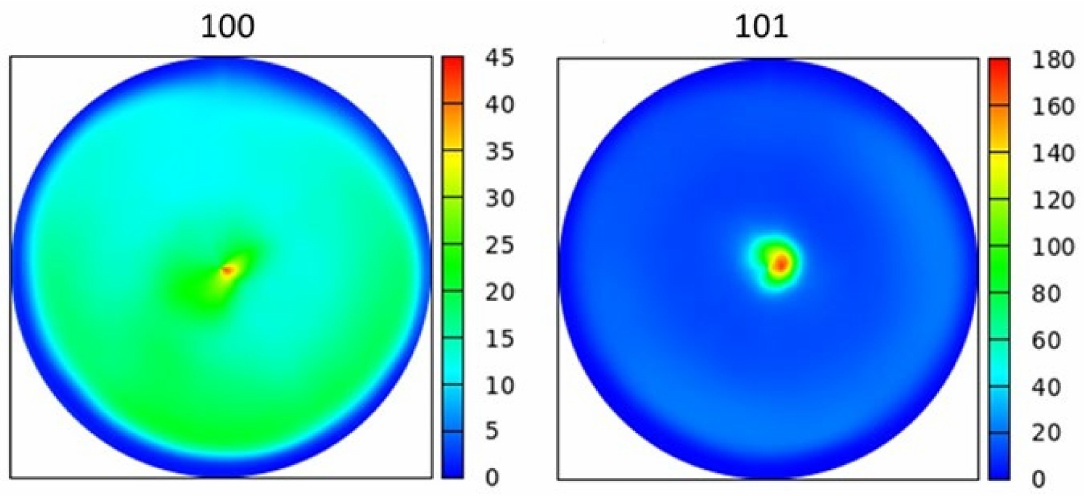
Figure 10. 100 and 101 XRD pole figures characterizing the texture of the major hcp phase at point No. 9.